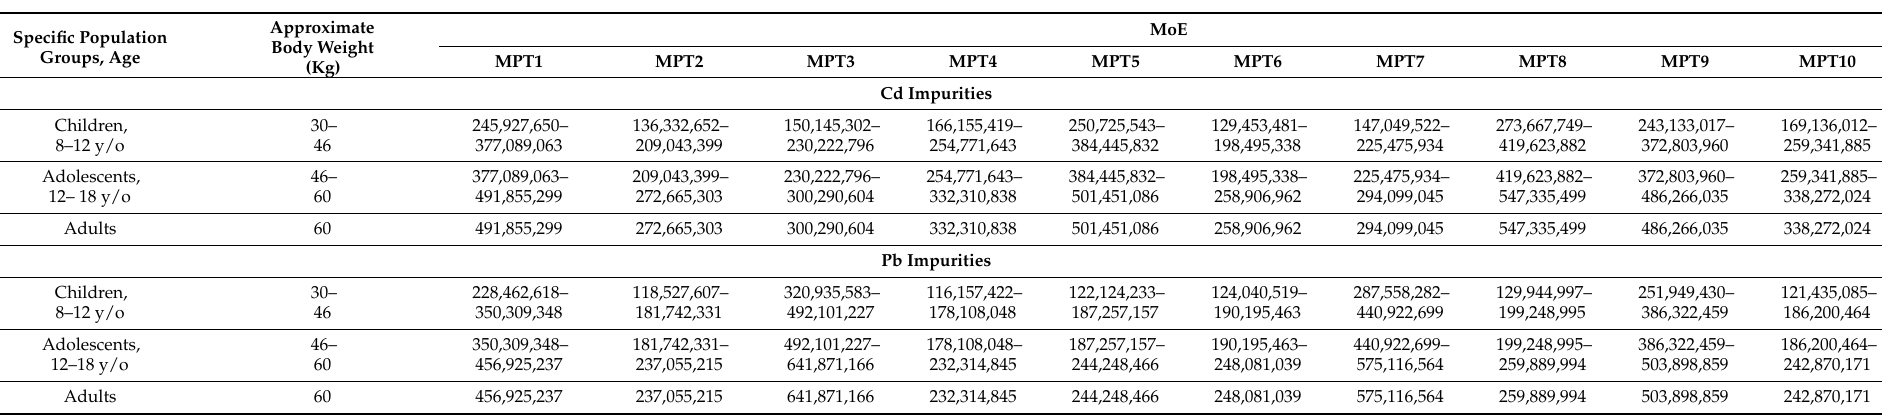
Table 6. Margin of exposure (MoE) calculated for Cd and Pb in daily dose for each sample (PMT1–PMT10) depending on age and body weight for each specific population